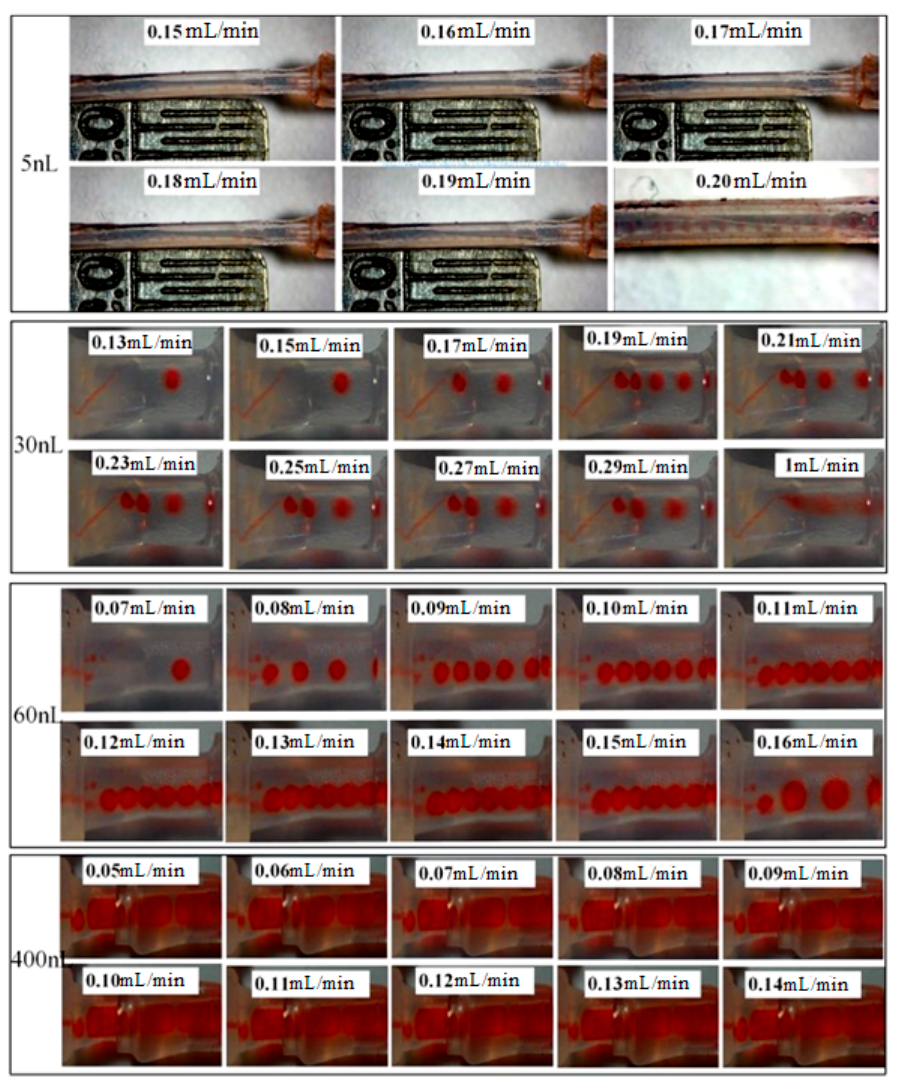
Figure A2. Morphology of four kinds of droplets.